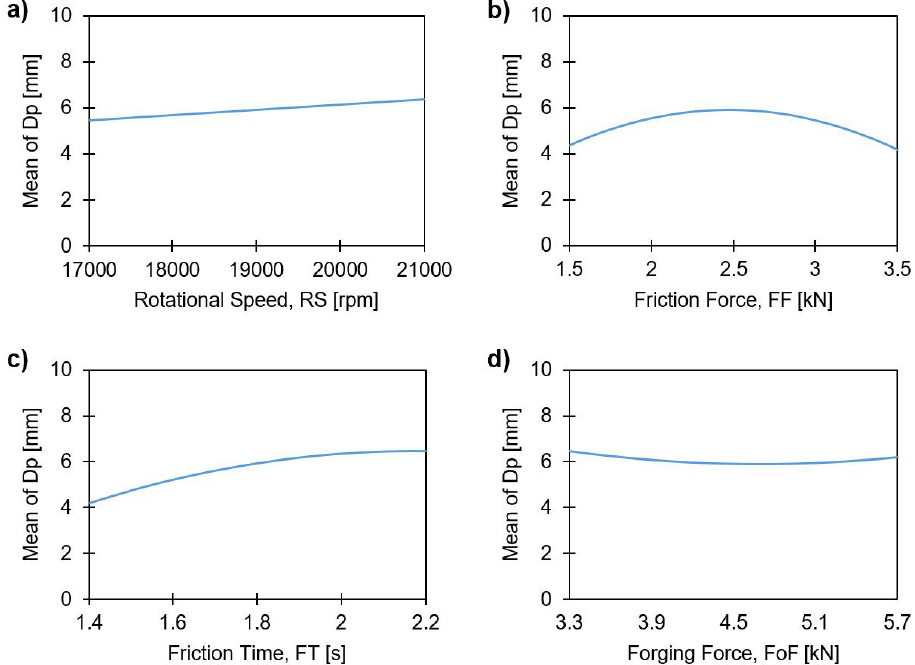
Figure 19. Main effects plots of the anchoring depth, Dp, with: ( a ) rotational speed; ( b ) friction time; ( c ) friction force; and ( d ) forging force.